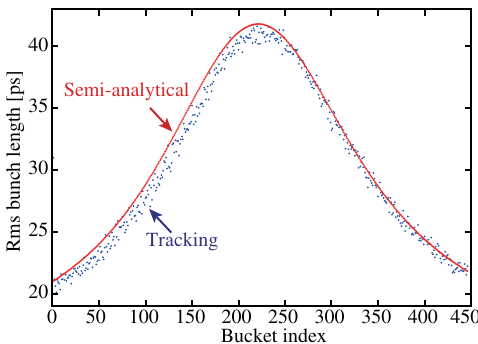
FIG. 5. Comparison of the bunch lengths obtained from the semianalytical calculation (red) and the tracking simulation (blue). Rms bunch lengths along one of the bunch trains are shown. We assumed the same parameters as those in Fig. 4.